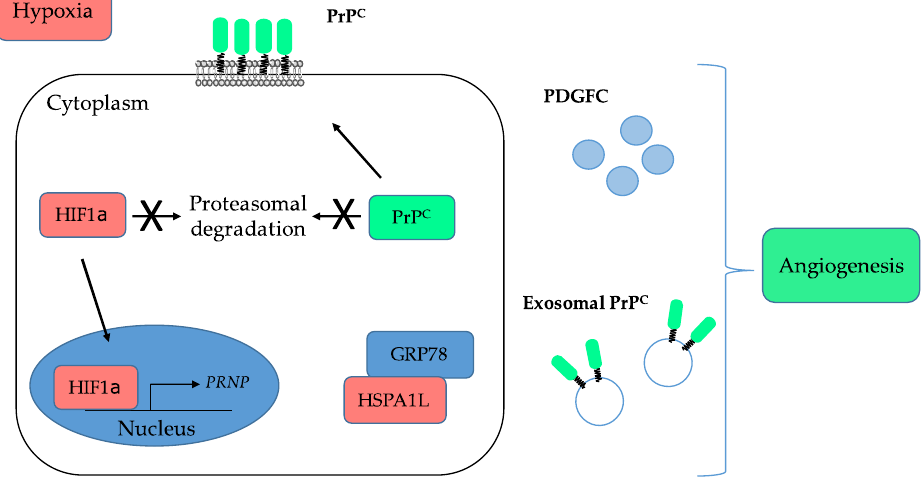
Figure 3. Summary of the interplay between PrP C and hypoxia and of the contribution of PrP C to angiogenesis. PrP C is induced under ischemic conditions and prevents the degradation of HIF1 α by the proteasome. On the other hand, under hypoxia, HIF1 α promotes the transcription of the PRNP gene, favours the sequestration of the GRP78 E3-ligase, leading to enhanced PrP C protein stability, and is associated with enhanced release of exosomal PrP C . PrP C may further sustain angiogenesis by controlling the levels of PDGFC.